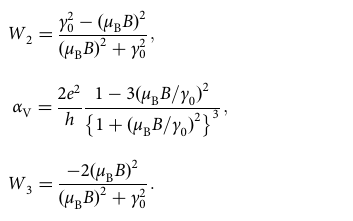
point. The dashed curve given by the NRG calculations again agrees with the experimental results well. We also show the phase shift, δ σ ( = δ ↑ = δ ↓ ), evaluated from Eq. (1) (circles in Fig. 4a). As expected, the phase is locked around π /2 and develops a plateau 39,40 . The NRG calculations indicate that the Wilson ratio does not decrease in this region (see Supplementary Note 2).